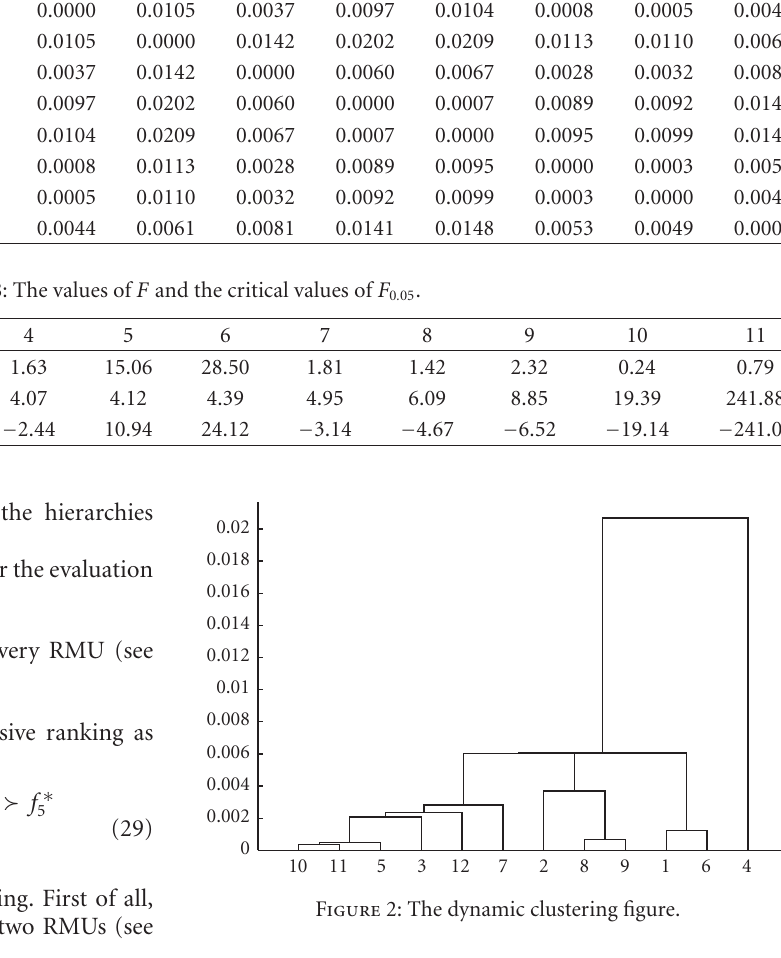
Figure 2: The dynamic clustering